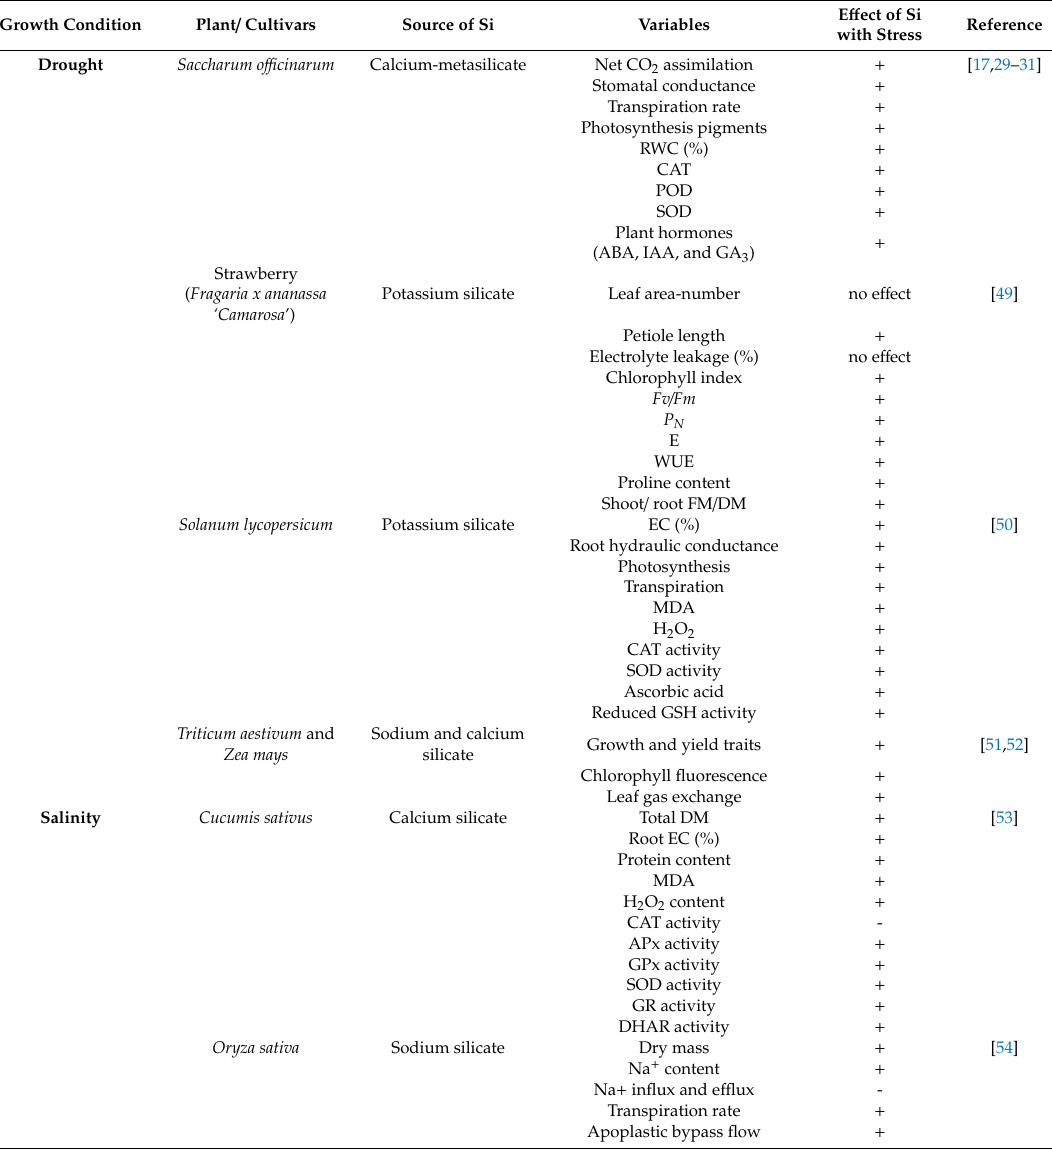
Table 1. Role of silicon on the growth, physiology, and biochemistry of